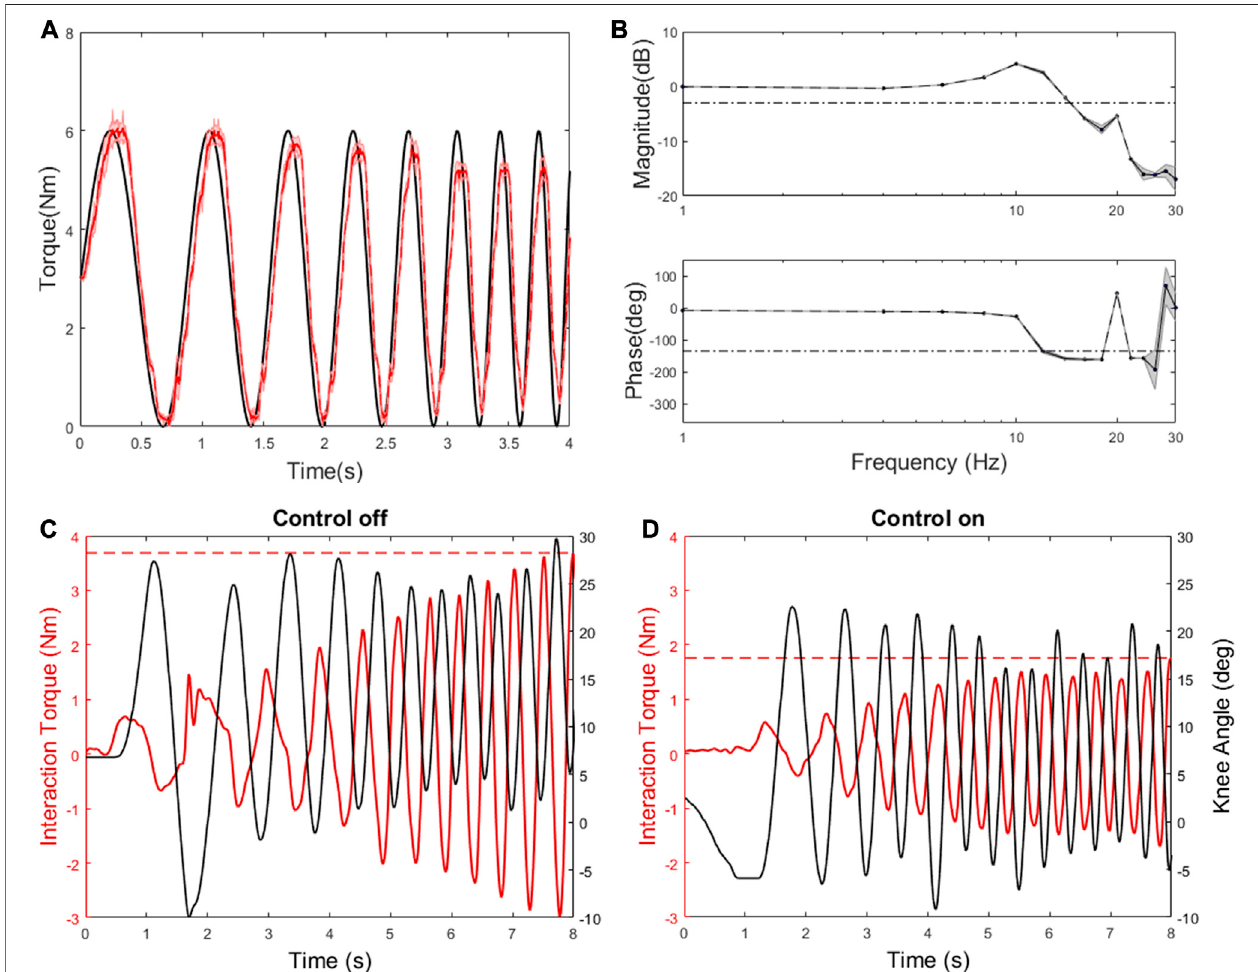
FIGURE 3 | Characterization results: (A) An example of torque tracking: the torque was measured (red) as a desired torque was commanded as 1 – 5 Hz chirp (black). (B) Bodeplot:thedashed linesrepresent − 3 dBinthemagnitudeplotand45degphasemargin inthephaseplot. (C) Theoutput wasmanuallyback-drivenwith the control off. The black line indicates knee angle. The measured torque (red) is due to re fl ected inertia and damping in the transmission. The dashed red line indicates maximum interaction torque. (D) With the torque control on and a desired torque of zero (i.e., Zero mode), the output is back-driven more easily.